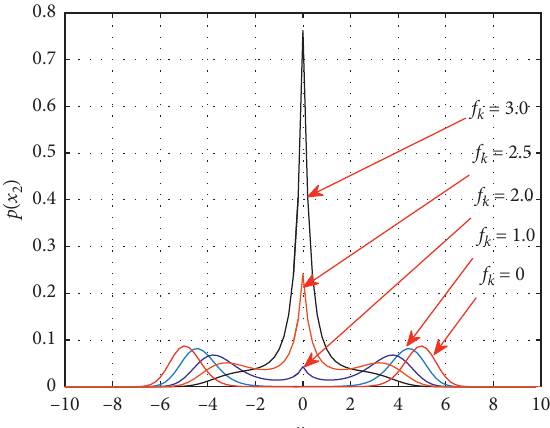
Figure 10: Section graphs of joint PDFs on the surface x different amplitudes of friction f k